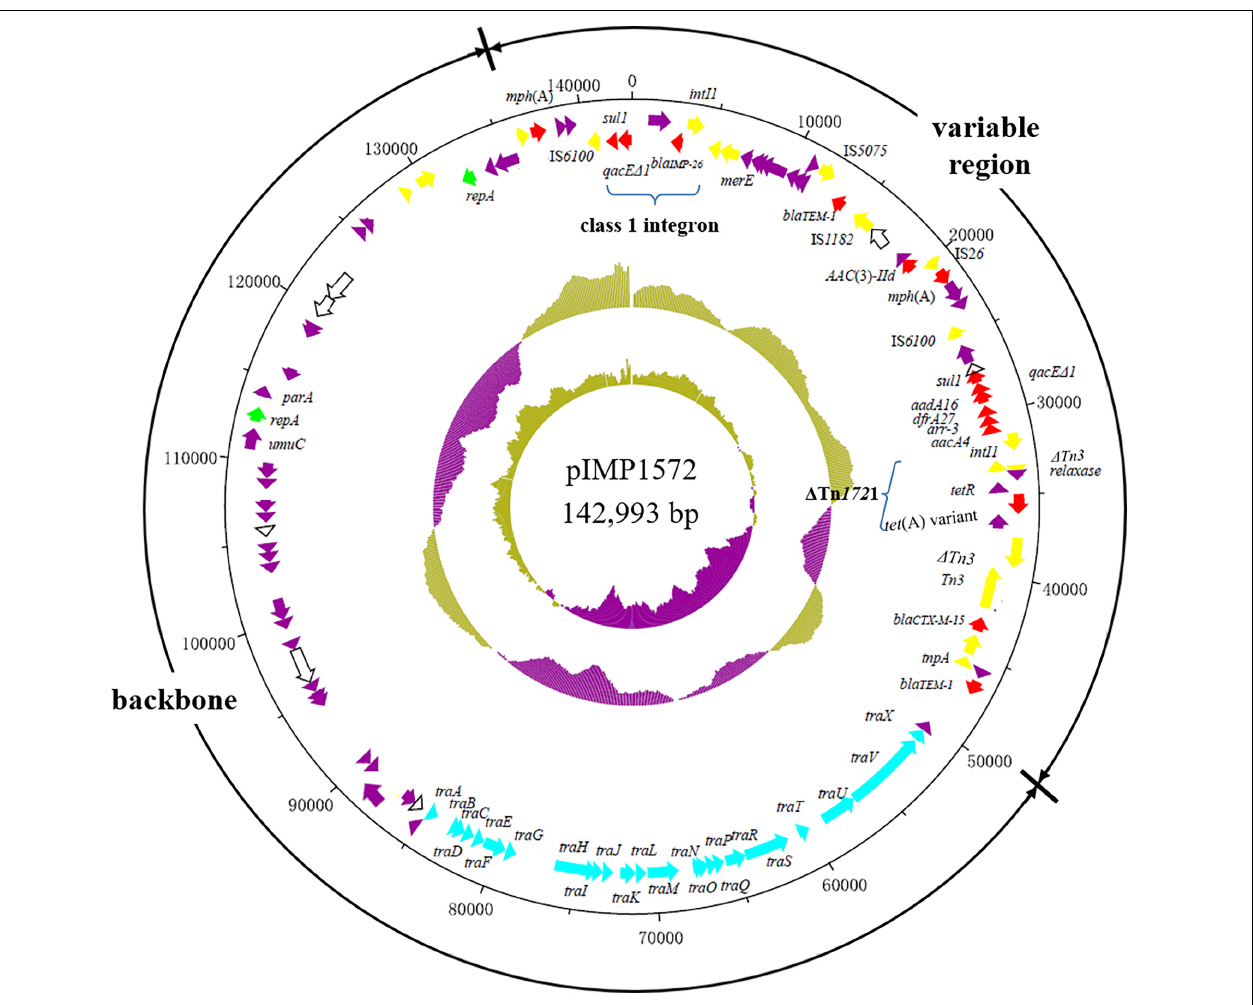
FIGURE 1 | The structure of the plasmid pIMP1572 from K. pneumonia KP-1572. The size scale in bp; genes are color-coded, depending on functional annotations: red, antimicrobial resistance; blue, plasmid transfer; green, plasmid replication; yellow, transposition; purple, other functions; and white, hypothetical proteins.